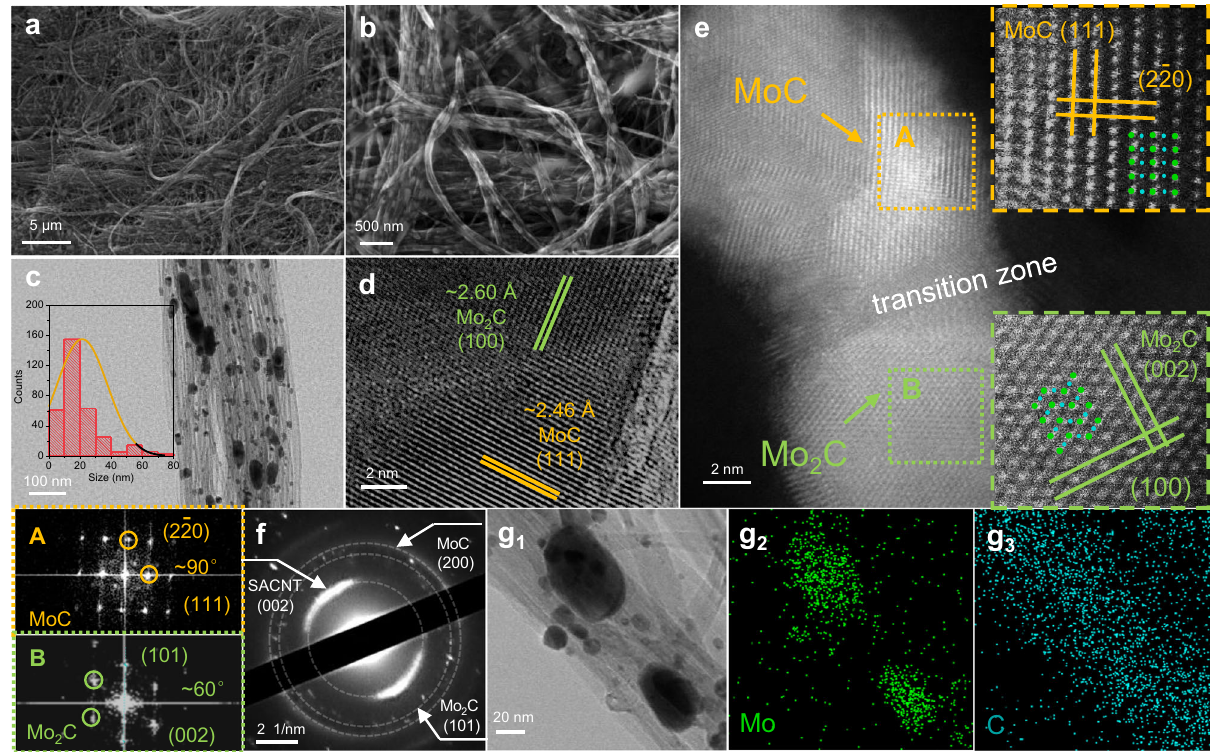
Fig. 3 Electron microscopic characterizations of Mo 2 C/MoC/CNT fi lms. a , b SEM images of Mo 2 C/MoC/CNT fi lm. c TEM images of Mo 2 C/MoC/CNT fi lm. The inset is the statistics of Mo 2 C/MoC particle size distribution. d HRTEM images of the interface between Mo 2 C (100) and MoC (111) in Mo 2 C/ MoC/CNT fi lm. e HAADF-STEM image of Mo 2 C/MoC. The inset is HAADF-STEM image of MoC phase and Mo 2 C phase, as well as the FT patterns. Green dots represent Mo atoms, and blue dots represent C atoms. f SAED pattern of Mo 2 C/MoC/CNT fi lm. g EDS mapping shows the distribution of Mo and C